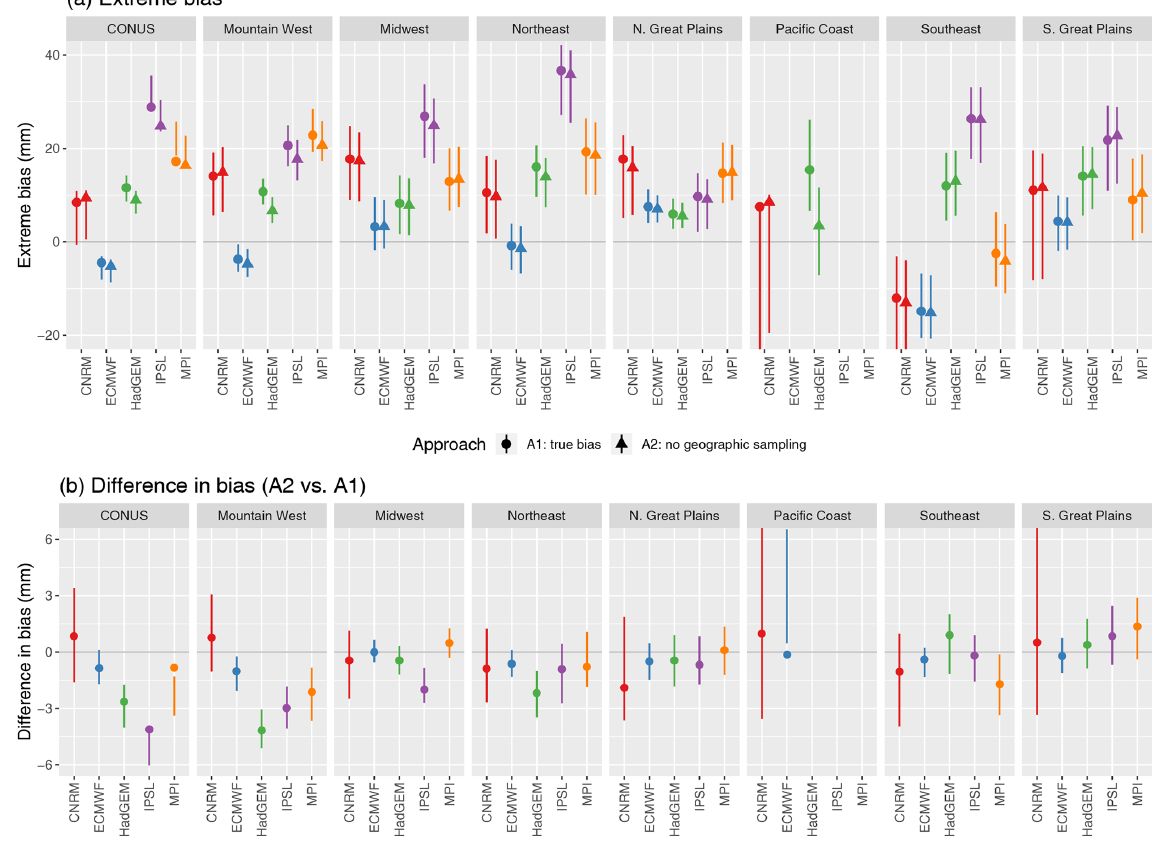
Figure 4. Extreme bias in CONUS and the climate subregions for each model (approaches A1, A2, and A3; panel a ), with difference in extreme bias for approach A2 (ignoring geographic sampling) versus A1 (b) . All estimates show the 90% basic bootstrap confidence intervals. Note that the extreme bias in the Pacific Coast region is significantly less than − 20mm for ECMWF and significantly larger than 40mm for IPSL and MPI (and are hence beyond the y axis limits in panel a ). Also, the difference in bias in the Pacific Coast is significantly less than − 10mm for HadGEM, IPSL, and MPI (and again are beyond the limits on the y axis in panel b